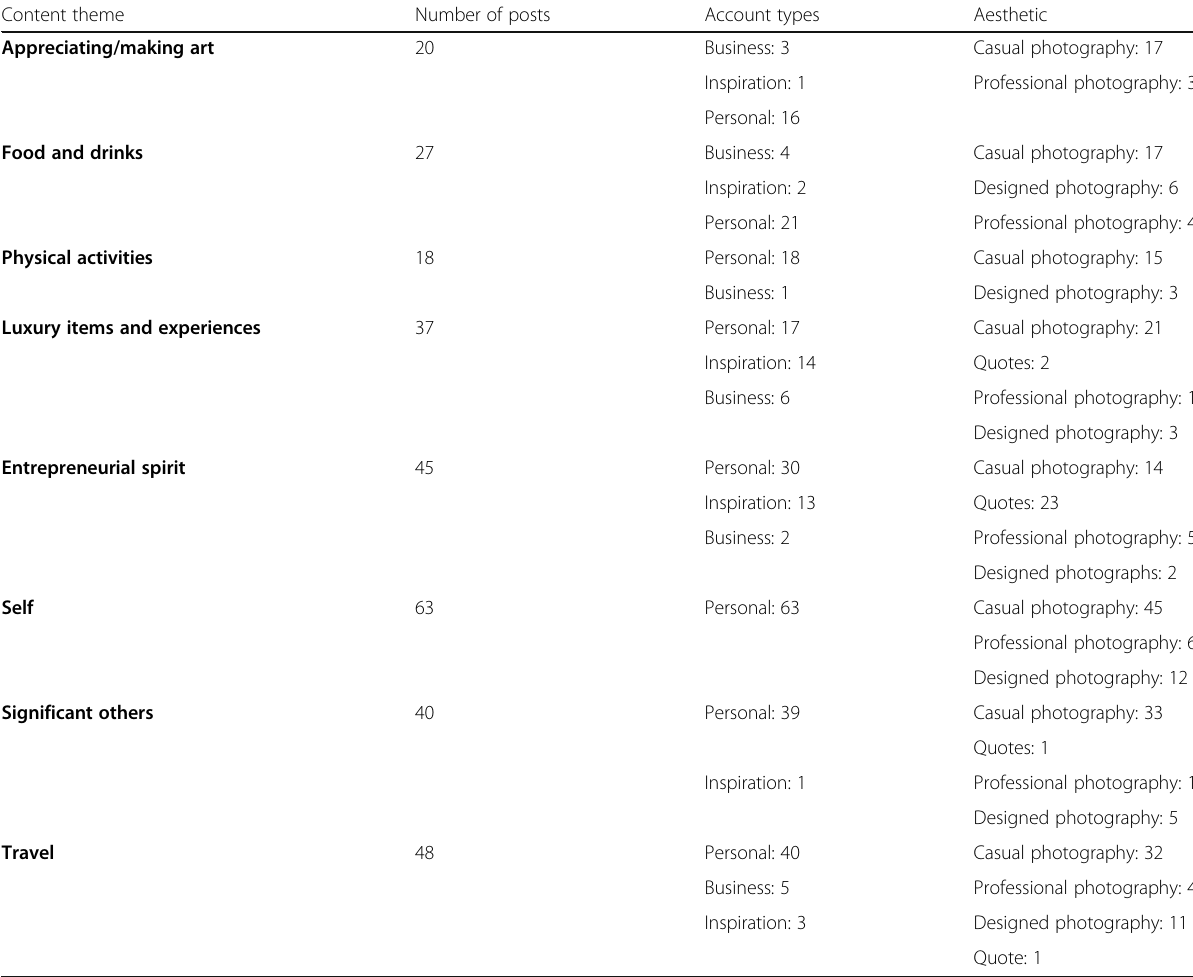
Table 2 Summary table of account type and aesthetics in 200 Instagram posts tagged #goodlife broken down by content theme Content